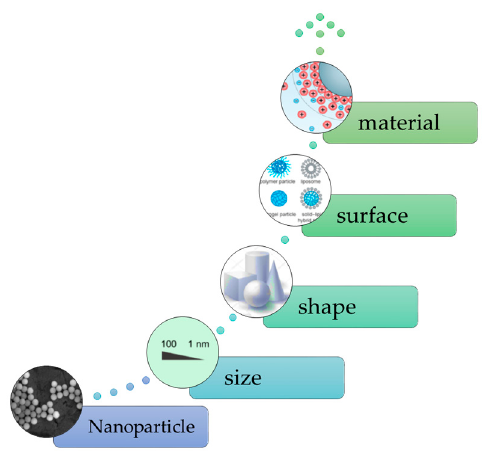
Figure 9. Important properties for engineering nanoparticles (NP) for photo-catalytic performance.